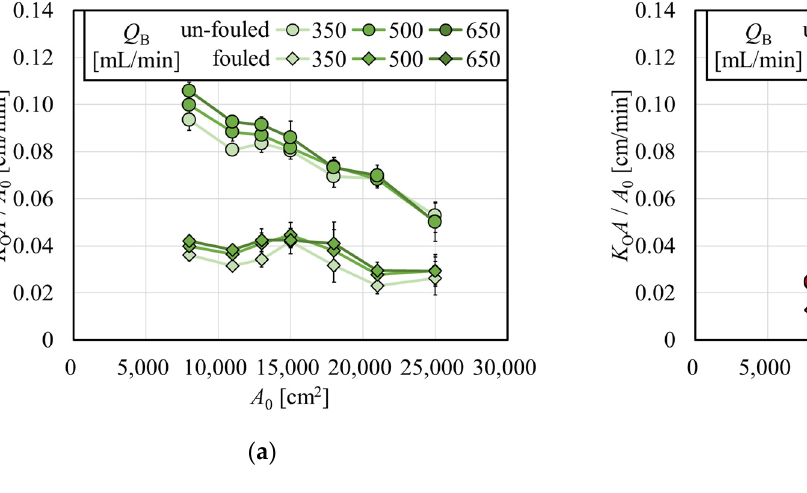
( c ) Figure 8. Overall mass transfer-area coefficient divided by A 0 ( K O A / A 0 ) for ( a ) creatinine, ( b ) vitamin B 12 , and ( c ) inulin. Clearances normalized to the effective surface area of 15,000 cm 2 ( C L15000 ) as a function of A 0 for creatinine, vitamin B 12 , and inulin are shown in Figure 9a, 9b, and 9c, respectively. Values of C L15000 for creatinine in the range A 0 > 15,000 cm 2 were lower than the value at A 0 = 15,000 cm 2 , which clearly shows that it is not recommended to estimate the clearance at A 0 = 15,000 cm 2 by using larger models since the clearance with A 0 = 15,000 cm 2 is used as standard representing the series of the same brand. On the other hand, values of C L15000 for vitamin B 12 and inulin did not show a particular decrease with the increase in A 0 under fouling. This is partly because the increase in the internal filtration flow rate in the large membrane surface area contributed to an increase in the solute removal performance. This effect has a greater impact on vitamin B 12 than on creatinine, which can sufficiently be removed by diffusion; however, the effect has a little smaller impact on inulin, whose sieving coefficient is significantly smaller than unity. Therefore, the improvement of so- lute removal by internal filtration may be dependent on the molecular size of the solute of interest as well as membrane permeability.